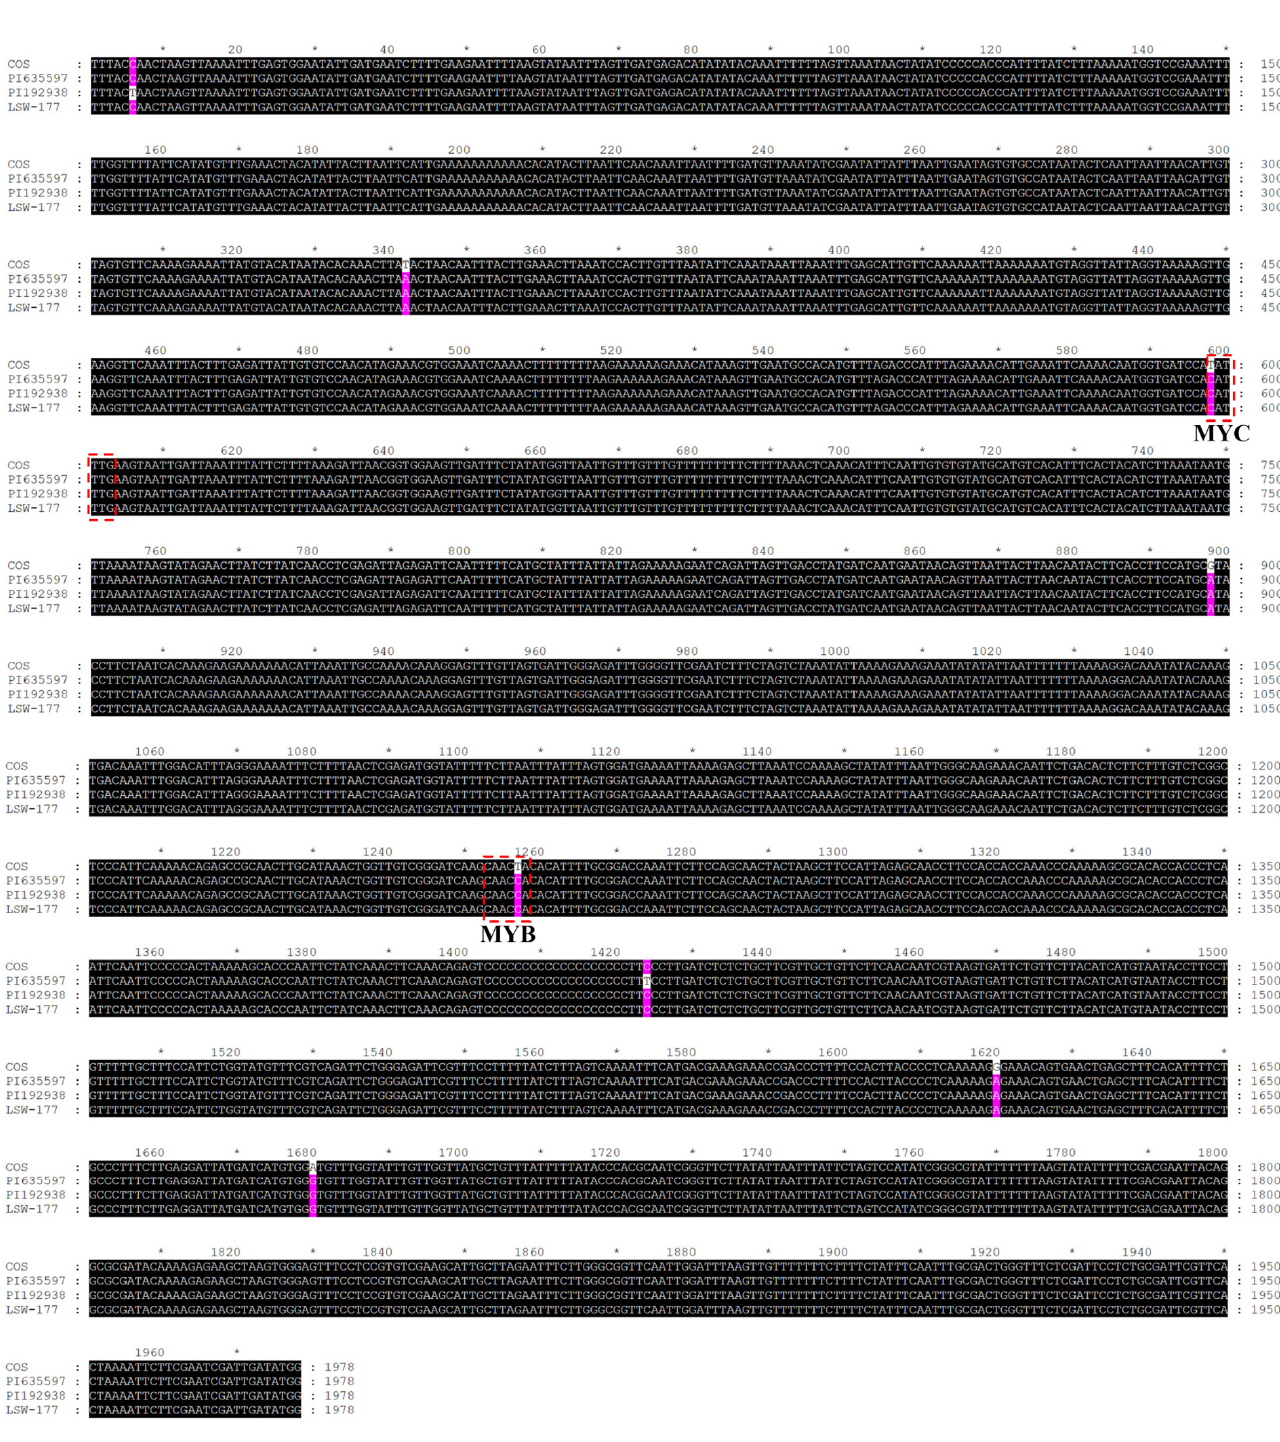
Figure 1. Sequence alignment of the ClPsy1 gene promoter from four different accession watermelons. The 5 ′ upstream promoter sequences of the ClPsy1 gene are shown. SNP variations in the pink colored area of the promoter regions. The * stands for ten nucleobases apart. First red dashed box stands for MYC cis ‐ element, the second refers to MYB cis ‐ element.